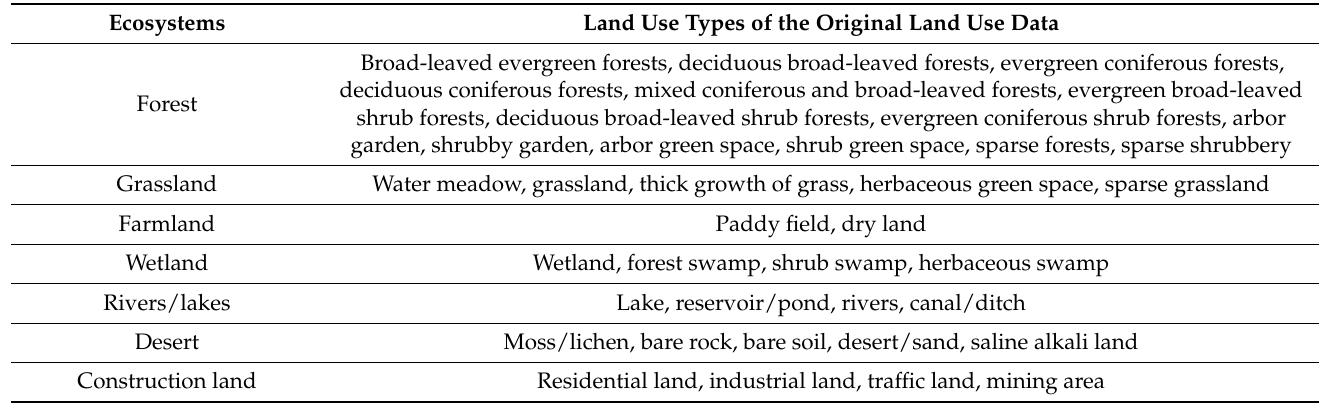
Table 1. Ecosystem types and reclassification of original land use data.